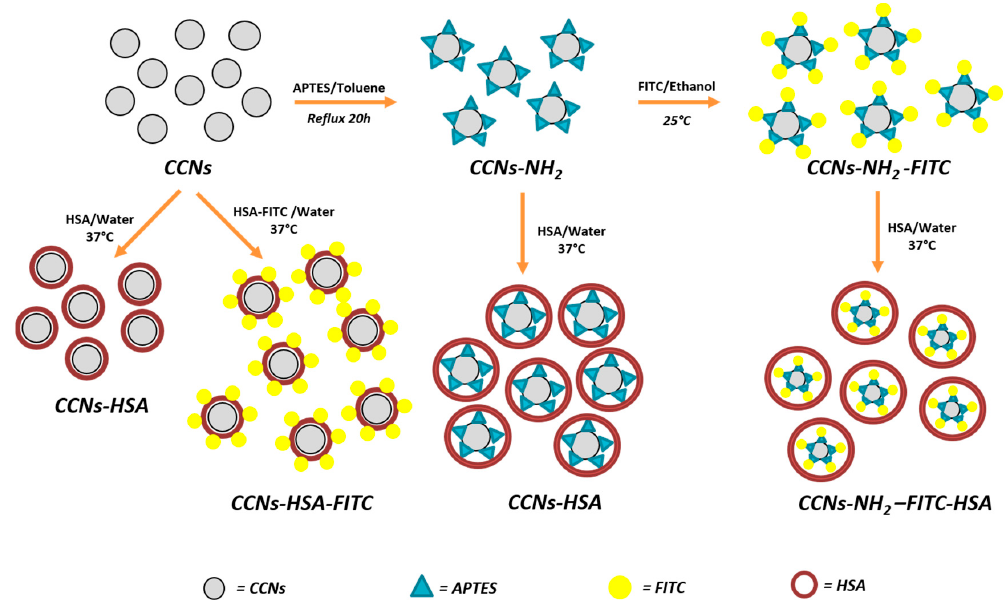
Table 1. Dynamic Light Scattering (DLS) characterization of CCNs